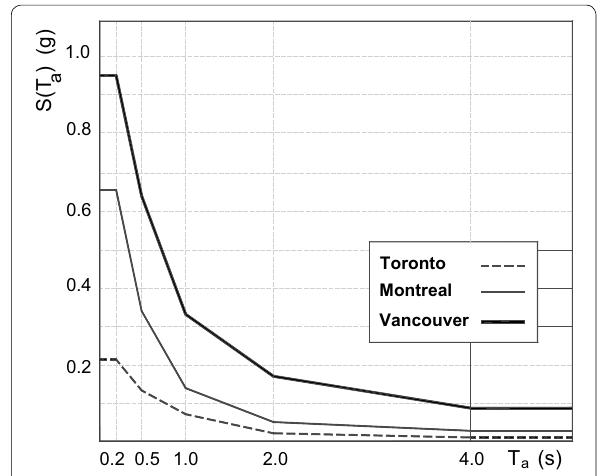
Fig. 3 The design response spectra of NBCC (2010) for Toronto, Montreal, and